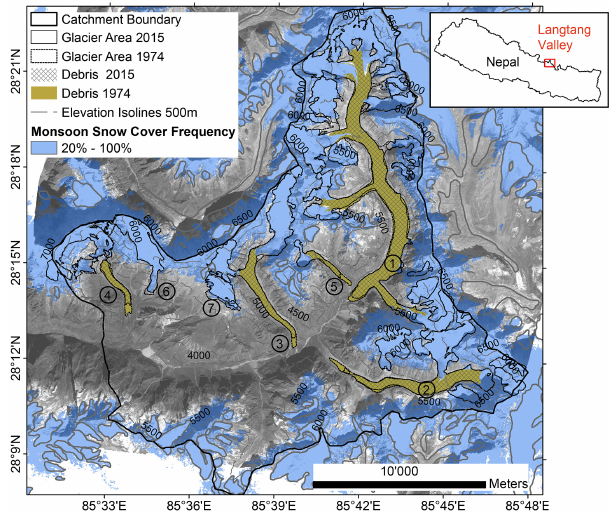
Figure 1. Map of the upper Langtang catchment. The numbers on the map correspond to the glaciers listed in Table 1. Monsoon snow- cover frequency is based on Landsat 1999 to 2013 land cover clas- sifications (Miles et al., 2016b). The 1974 glacier area (dotted lines) is shown for the seven studied glaciers